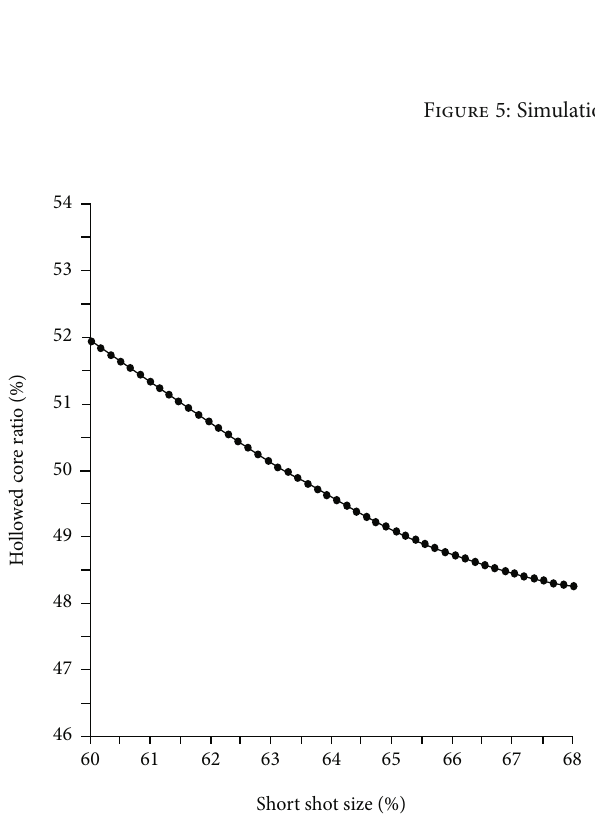
Figure 6: E ff ect of short shot size on hollowed core